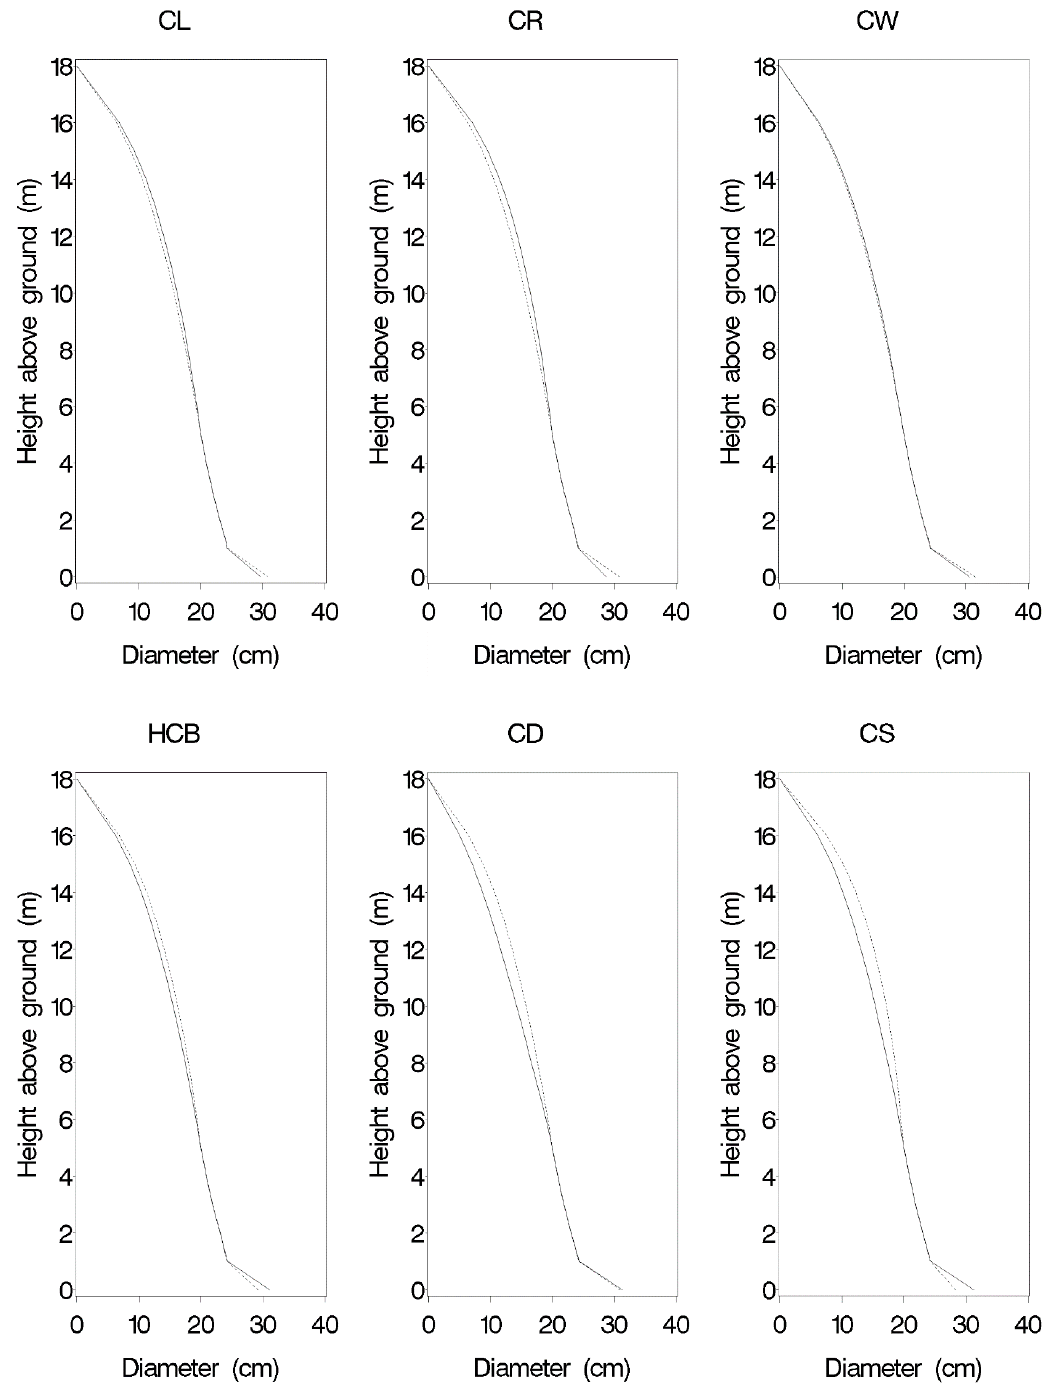
Figure 7. Tree profiles generated from the Clark model with crown variables with the same values of DBH (24.0 cm) and total height (18.0 m) by the different values of CL (4 and 14 m), CR (0.2 and 0.7), and HCB (5 and 15 m) for Manchurian fir. (For Figures 5–7: Solid lines represent lower values and dotted lines represent higher values.)